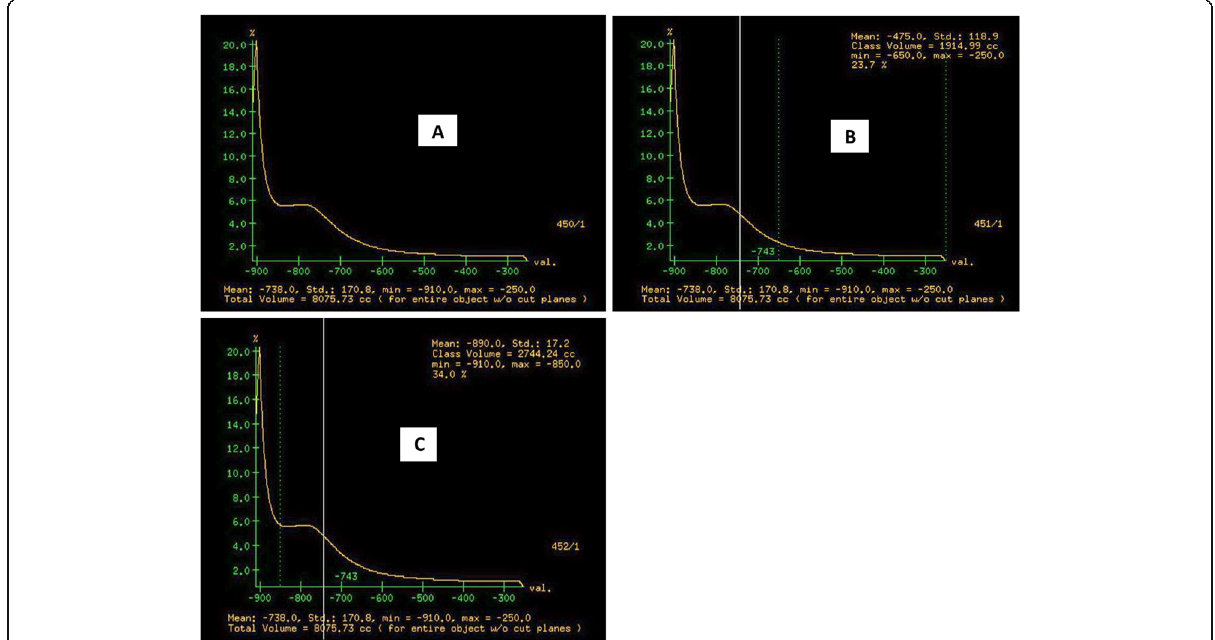
Fig. 4 CT histogram analysis a showing total lung volume (TLV) and mean lung density (MLD) between threshold densities − 250 and − 910 HU, b showing the percentage of the lung occupied by high attenuation areas (HAAs %) about 23.7%, and c showing the percentage of lung occupied by low attenuation areas (LAAs %) about 34%